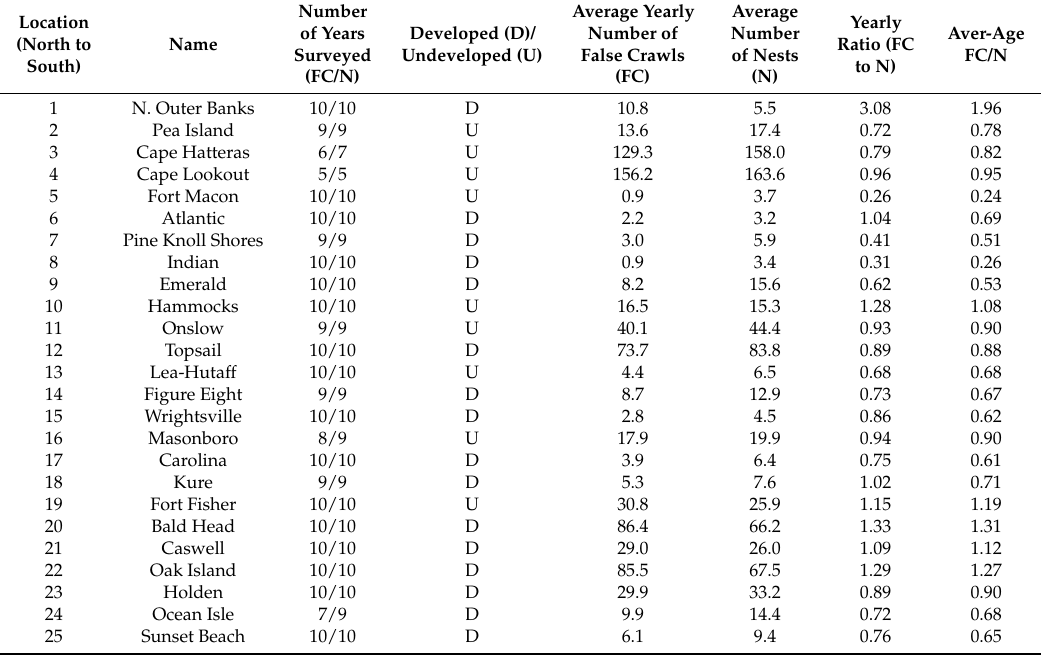
Table 3. Number of false crawls (FC), nests (N), yearly ratio of FC to N, and average FC to N ratio for each beach/island in North Carolina from 2005 to